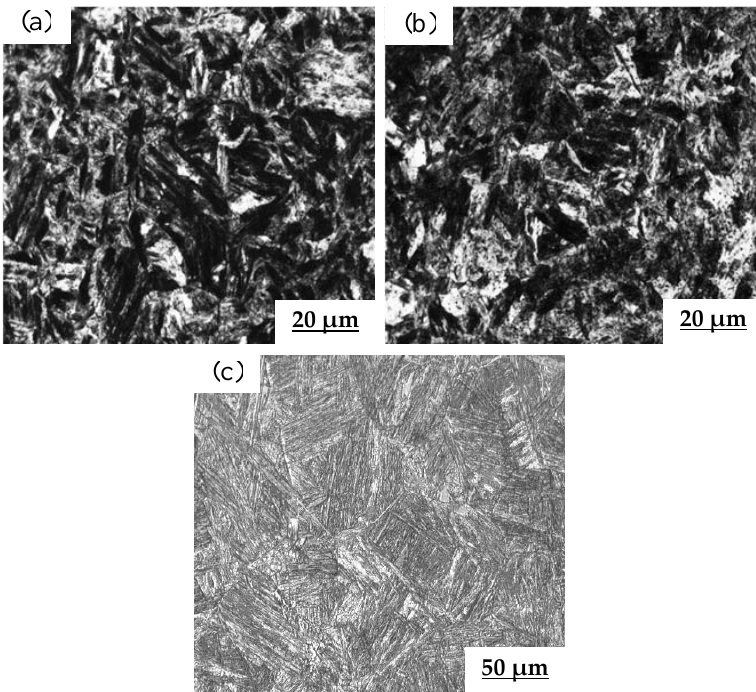
Figure 3. Optical microscopy (OM) micrographs of 17Cr2Ni2MoVNb steel quenched at different temperatures of ( a ) 900 °C, ( b ) 1000 °C, and ( c ) 1100 °C.